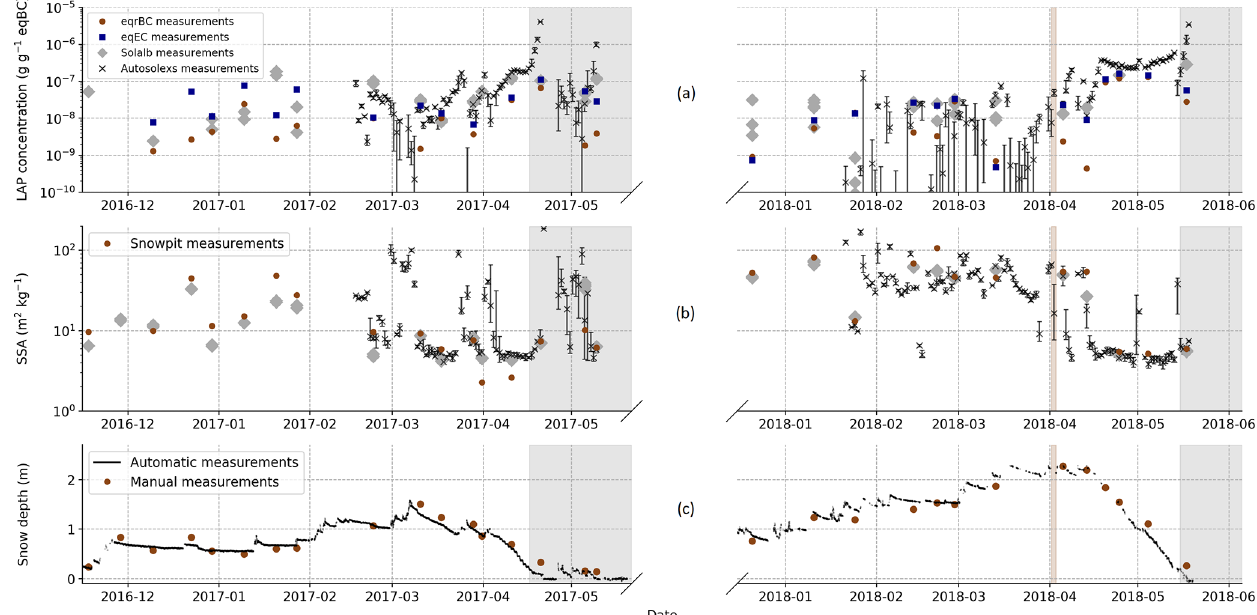
Figure 3. Evolution of measured near-surface LAP concentrations (a) , near-surface SSA (b) and snow depth (c) . Information retrieved from automatic spectral albedo (Autosolexs) is represented by black crosses with error bars corresponding to the 25% and 75% quantile of all the measurements of the day. Information retrieved from manual spectral albedo (Solalb) is represented by grey diamonds. Snow pit SSA and eqrBC concentrations are represented by brown dots, and eqEC concentrations are represented by blue squares. The major dust deposition event of the second year is represented by the vertical brown